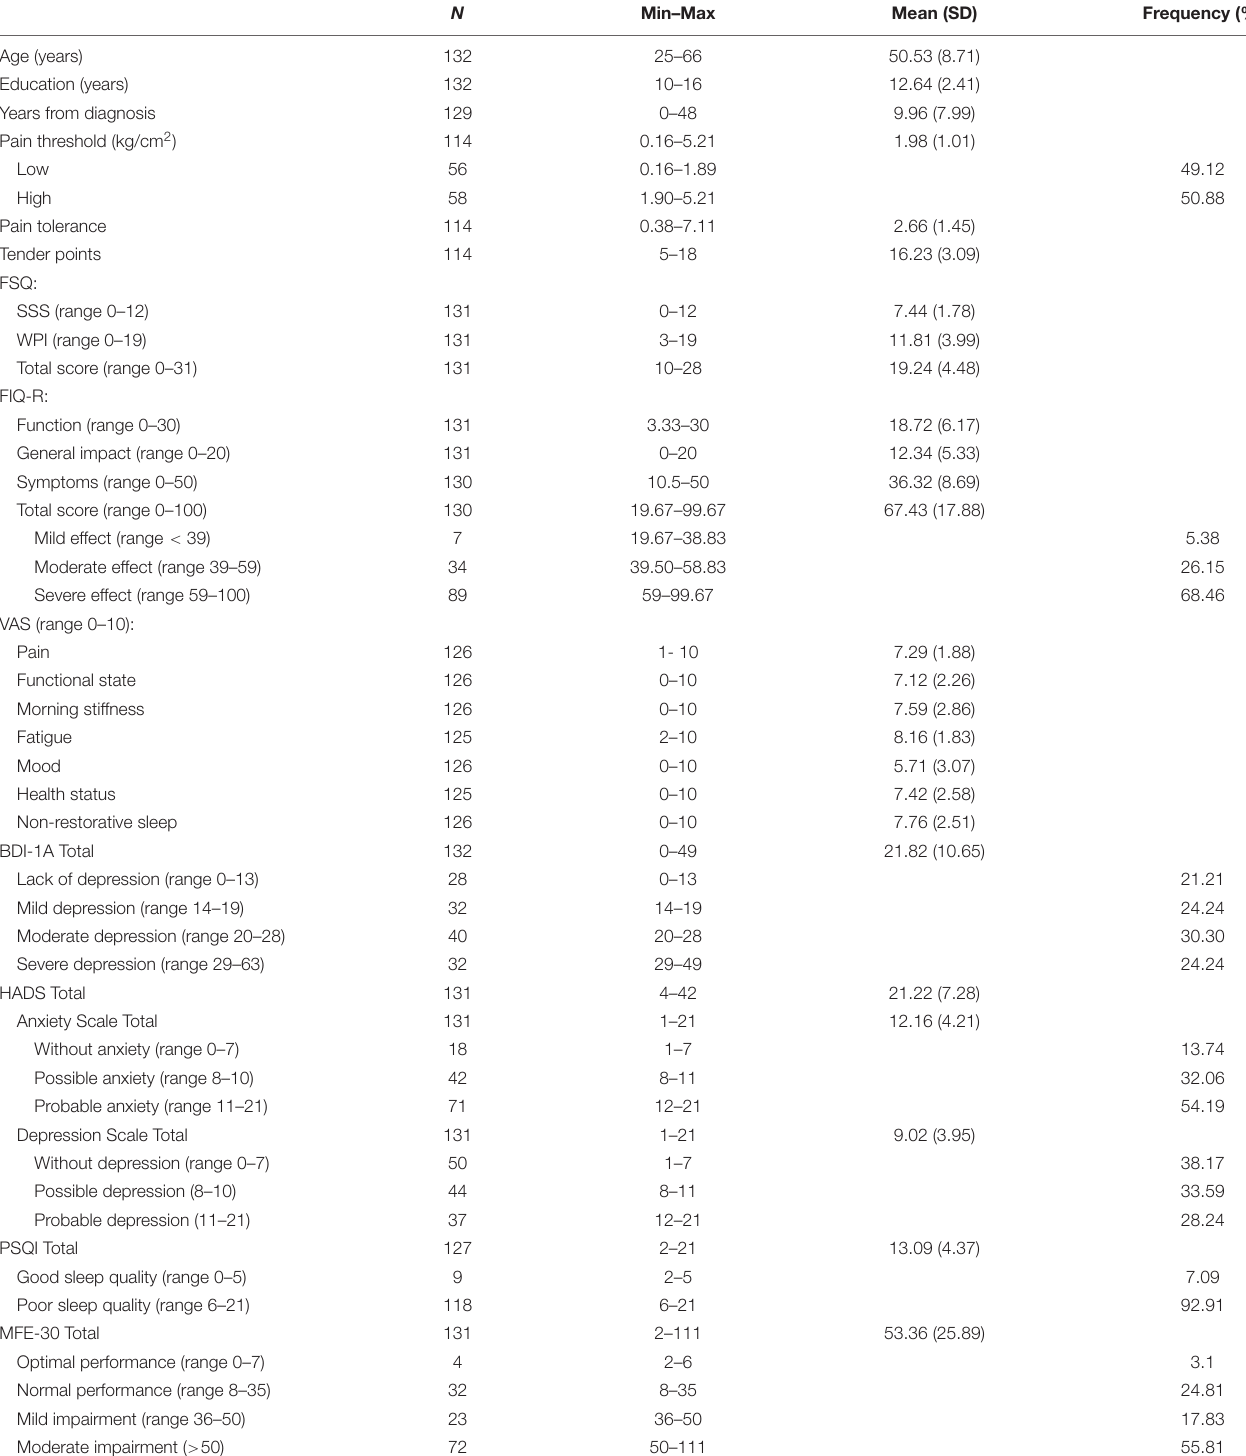
TABLE 1 | Demographic, clinical and self-reported characteristics of fibromyalgia